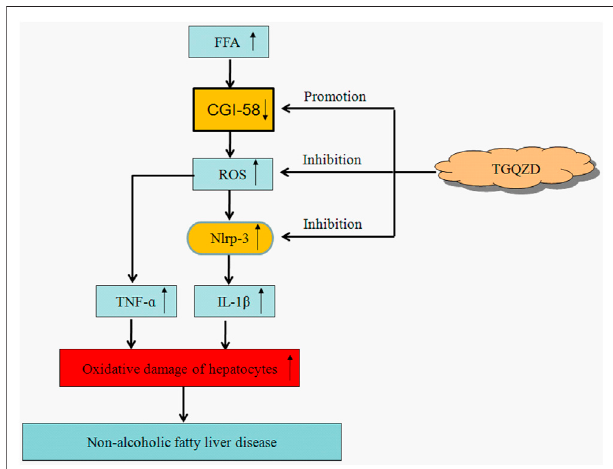
FIGURE 9 | The therapeutic effect of TGQZD on NAFLD rats. Based on the above, TGQZD can reduce the accumulation of lipid in liver by regulating the level of lipoproteins; improved hepatic function; inhibit FFA and promote CGI-58 expression to suppress activating the ROS-dependent NLRP3 in fl ammasome pathway, which reduce the liver in fl ammation